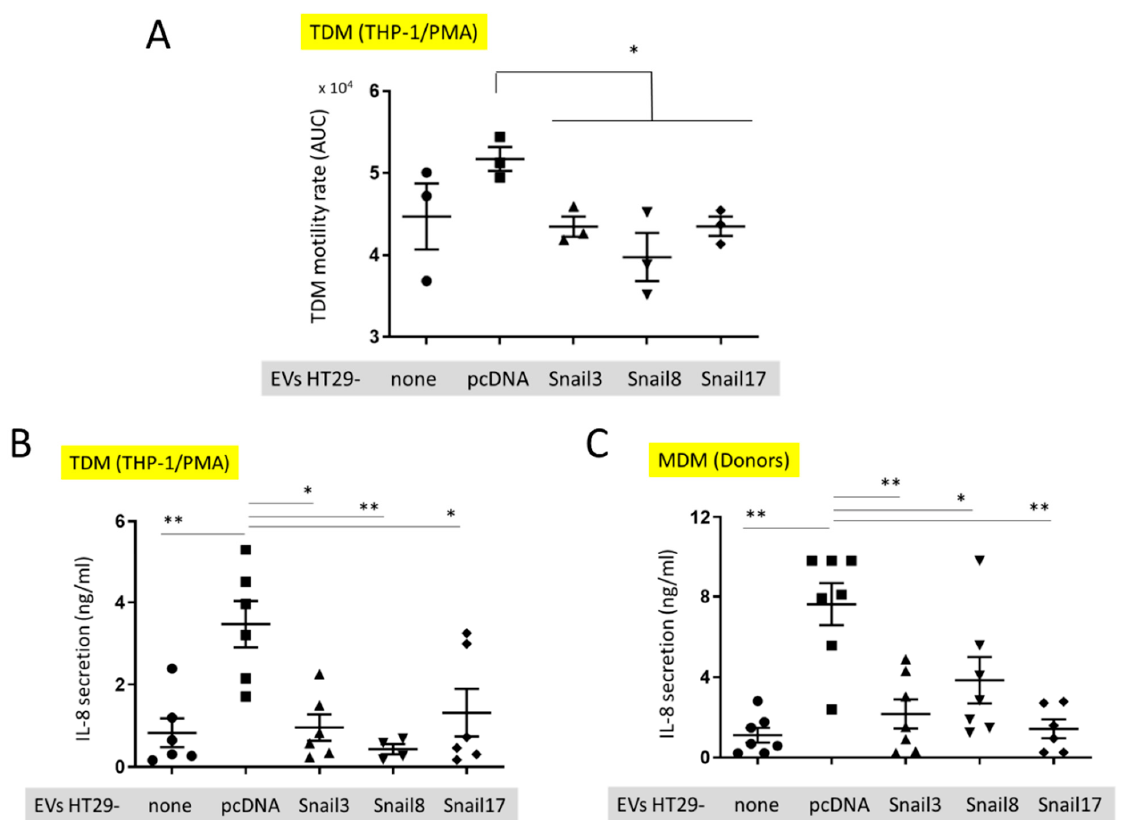
Figure 5. In vitro effect of EVs on macrophages. ( A ) Motility of TDM cells before (small dot) after the uptake of EVs isolated from control HT29-pcDNA (small cube) or HT29-Snail cells (clone 3- small triangle, clone 8- small upside triangle and clone 17- diamond). ( B ) IL-8 release from TDM after treatment with EVs indicated. ( C ) IL-8 release from macrophages isolated from healthy donors blood (MDM) and incubated with EVs. n = 3–7, * p < 0.05; ** p < 0.01.